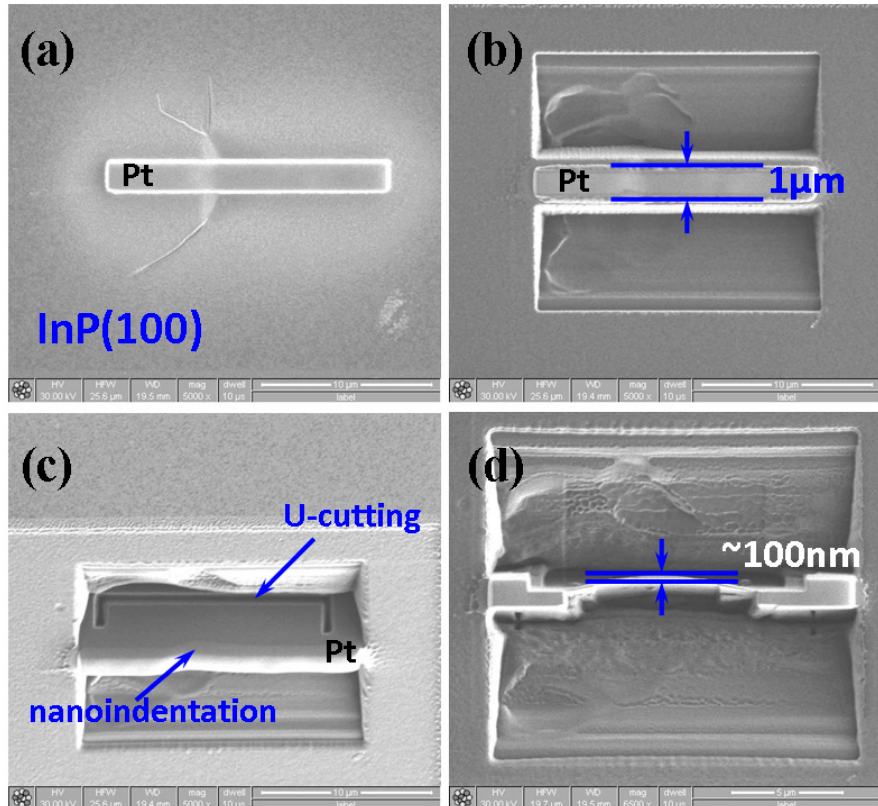
Figure 2. A typical procedure of focused ion beam (FIB) milling for single-crystal InP(100) is shown. Sample preparation starts with a line of nanoindentations. After depositing a protection layer of Pt ( a ), two big trenches are etched on either side of the indentation line by a high current ion beam (7~20 nA) ( b ) Further, the middle strip is thinned ( c ). An ion dose of 50 pA is used for final clearing steps and, finally thinned to a thickness of ~100 nm ( d ).